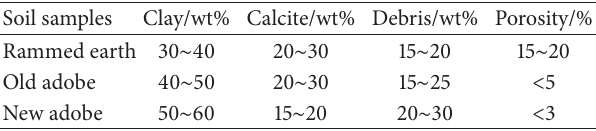
Table 1: Microscopic observation results of soil